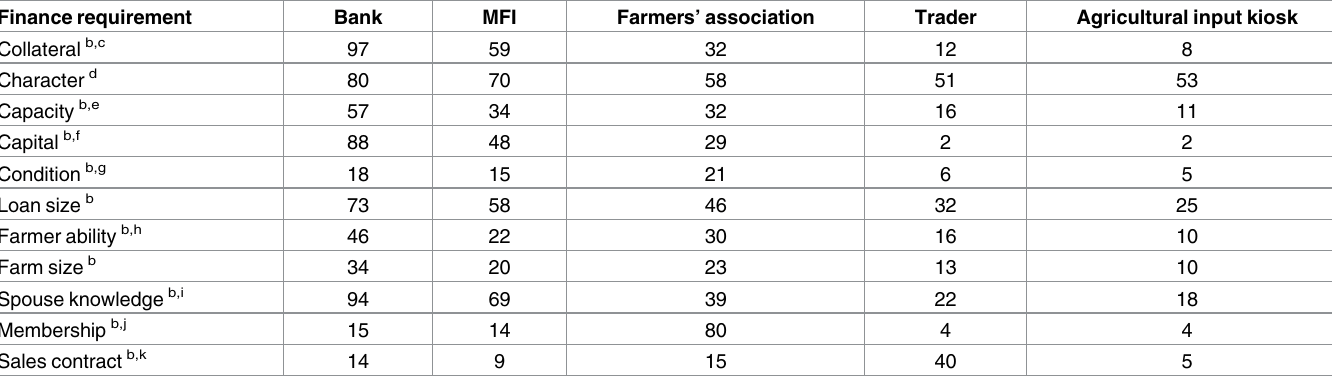
Table 3. Farmers’ perceptions of the important requirements to obtain finance per finance provider type a (n =